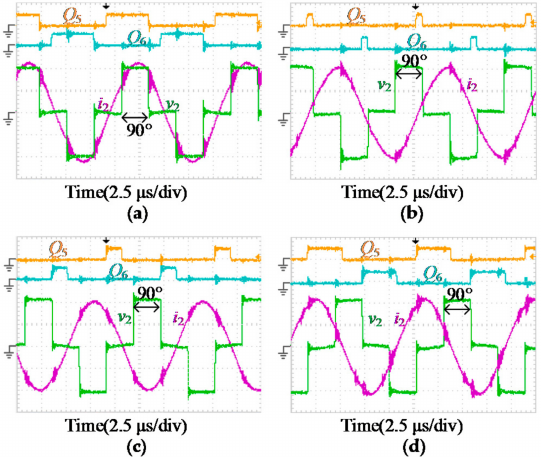
Figure 13. Experimental results of proposed dead-time elimination method. ( a ) Region 1; ( b ) Region 2; ( c ) Region 3; ( d ) Region 4. Q 5 – Q 8 : 5 V/div; i 2 : 5 A/div; v 2 : 50